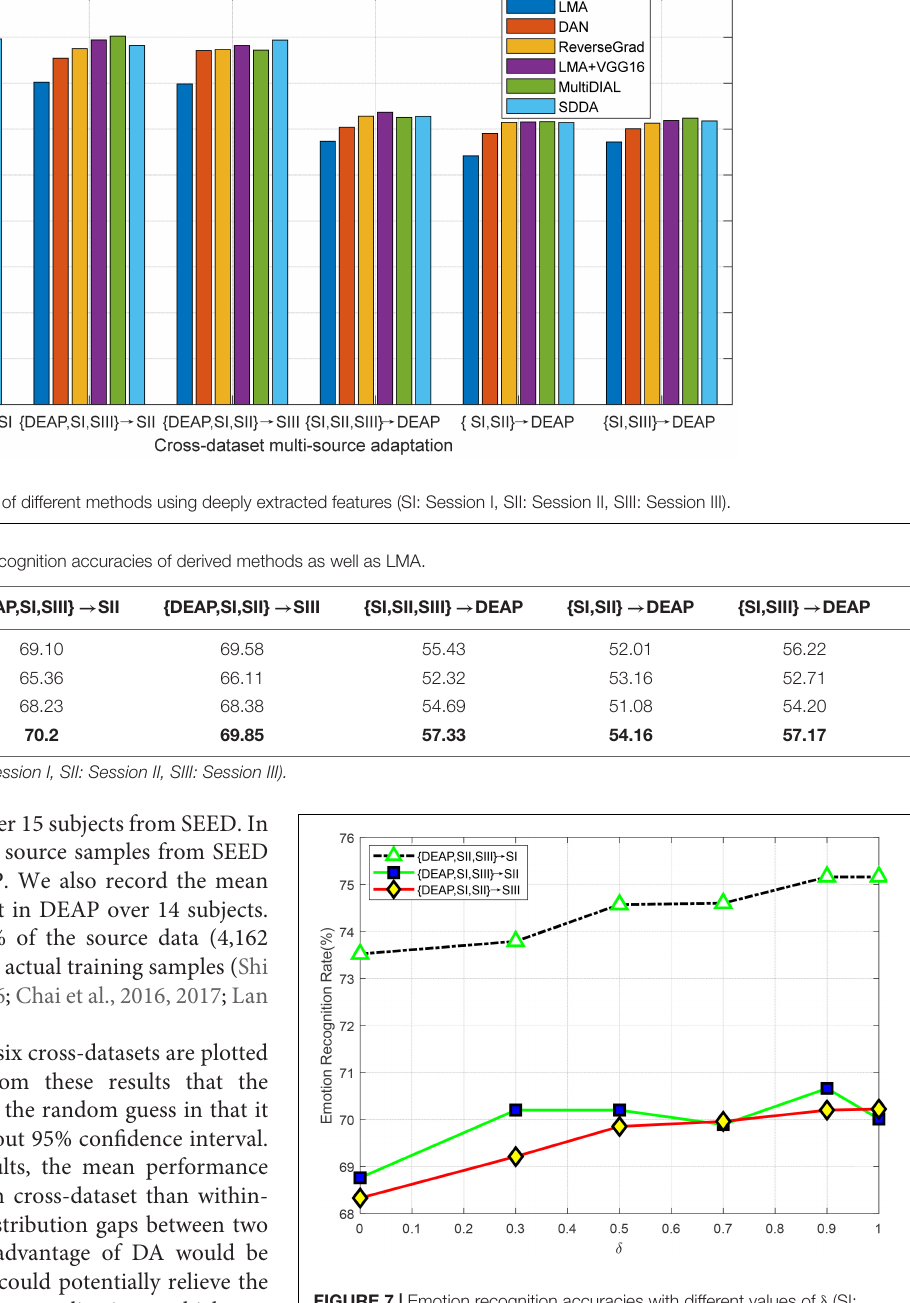
FIGURE 7 | Emotion recognition accuracies with different values of δ (SI: Session I, SII: Session II, SIII: Session